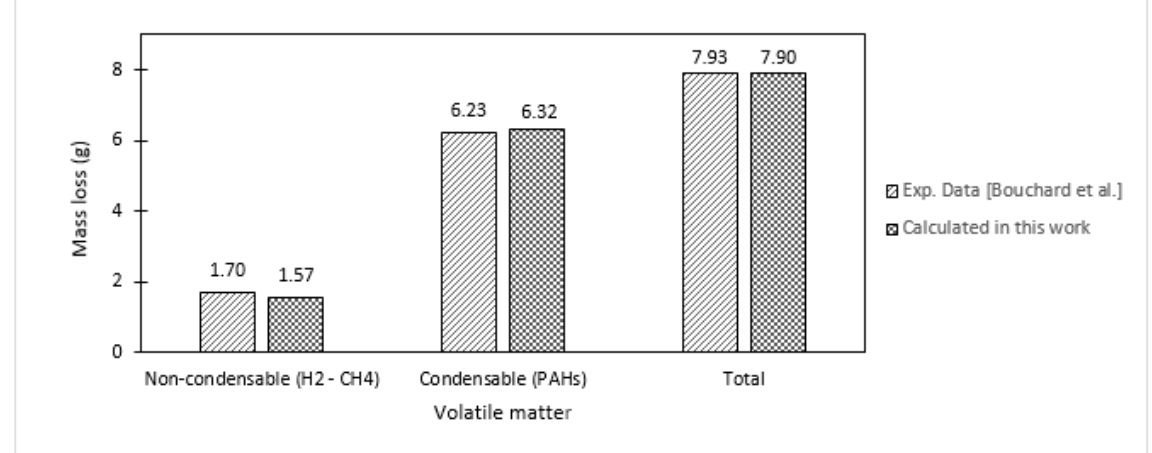
Figure 12. Calculated released volatile matters from a 50 g coal tar pitch heat treated from T amb to 450 °C with heating rate of 50 °C/h (Experimental data obtaine from work of Bouchard et al in ref. [28]).